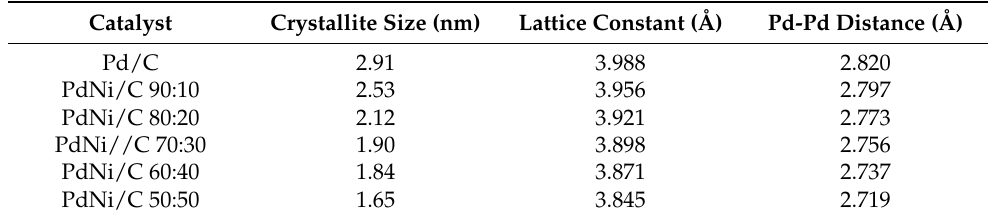
Table 1. Structural characteristics of carbon-supported Pd/C and PdNi/C nanocatalysts derived from XRD data.